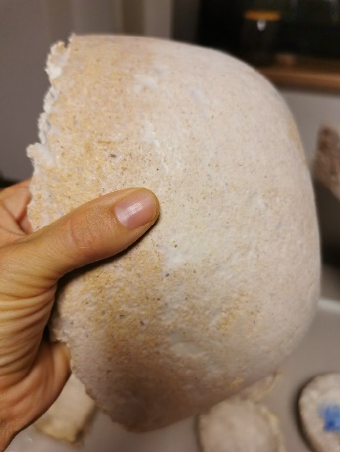
Figure 7. Mycelium-based material after growth: smooth surface with (design and photo: A. Bonenberg).